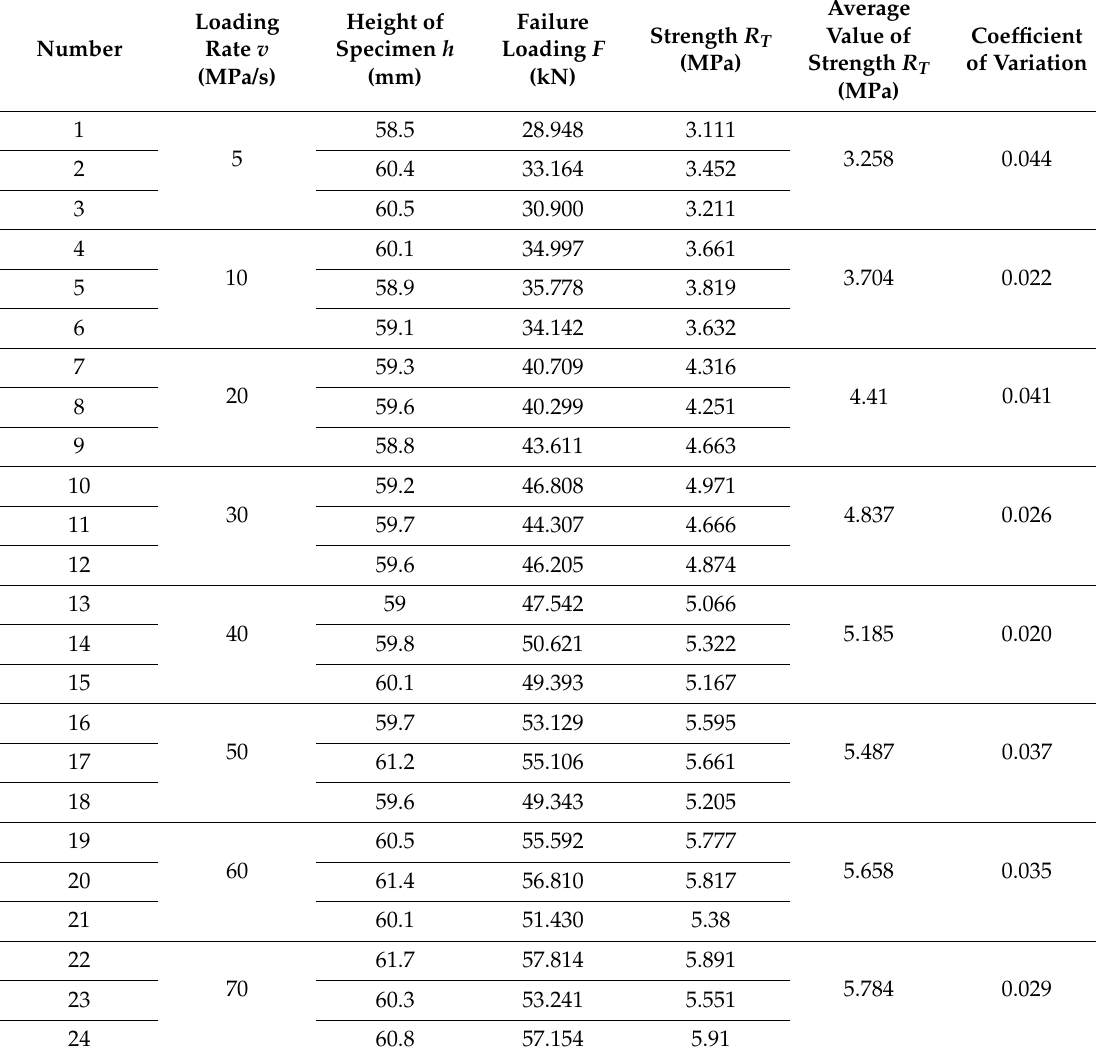
Table 6. Indirect tensile strength test of asphalt